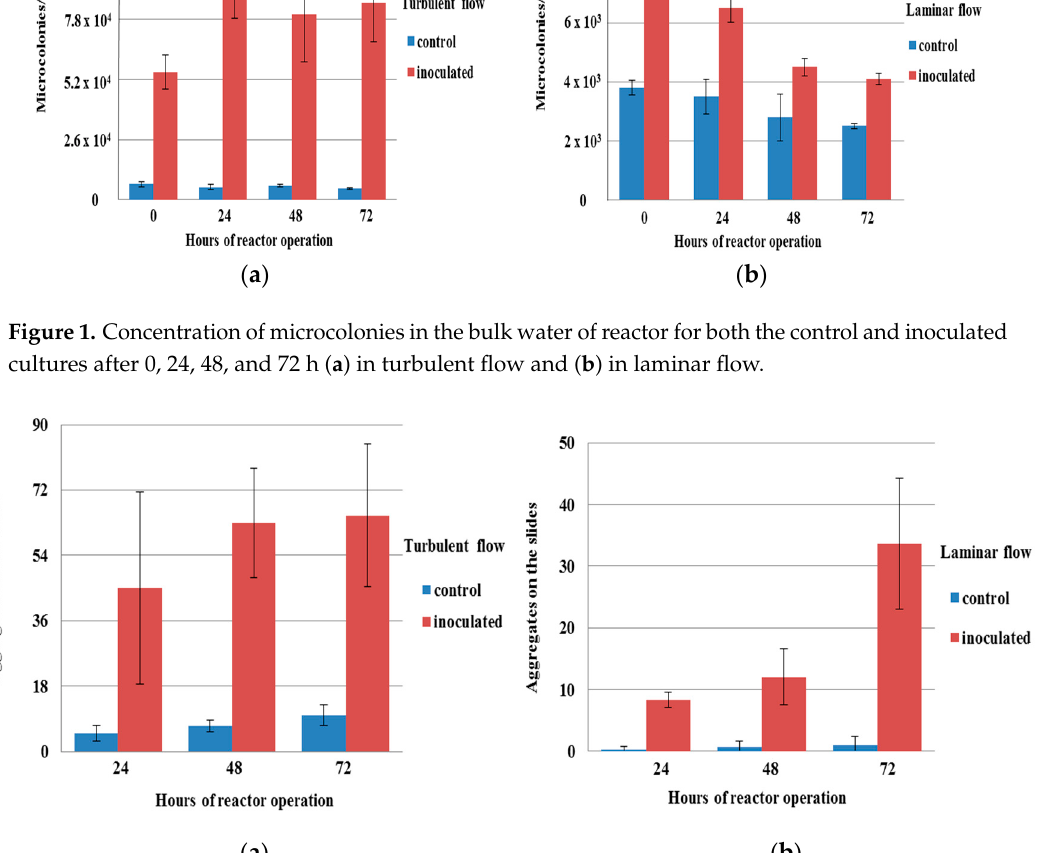
Figure 3. Percentage of surface area of biofilms from the bulk water of reactor for both the control and inoculated cultures after 0, 24, 48, and 72 h ( a ) in turbulent flow and ( b ) in laminar flow.